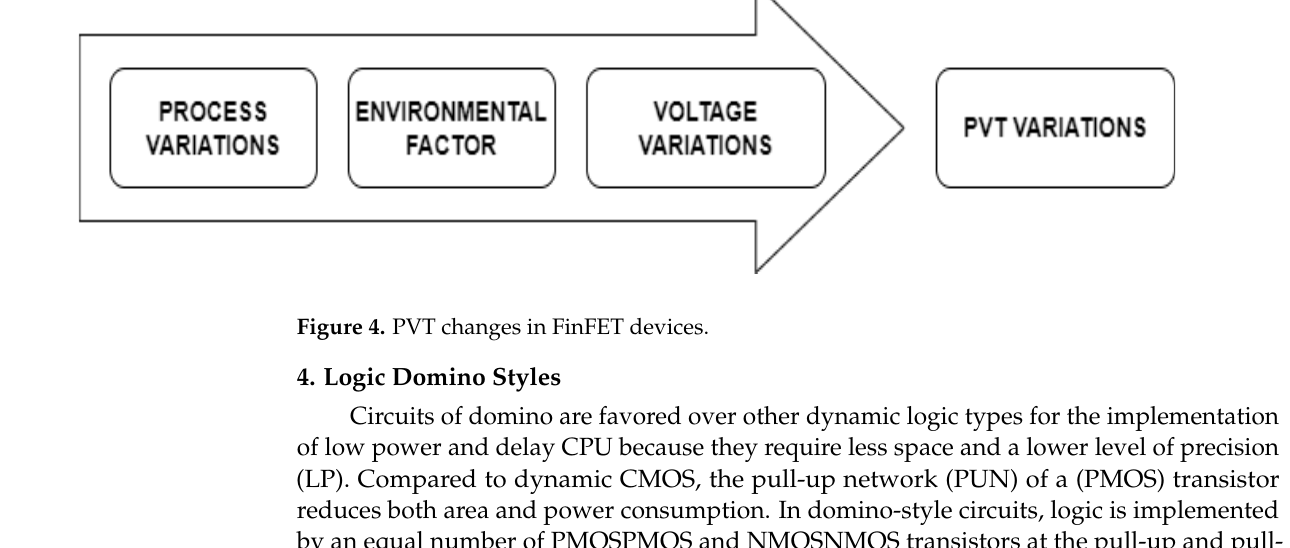
Figure 3. Relationship between system performance, device specifications, and processing.